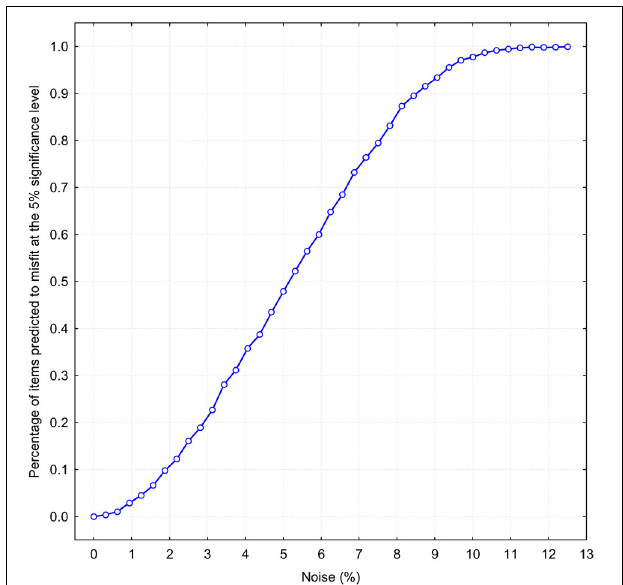
FIGURE 5 | Observed (blue) and predicted (red) response probabilities for the self-rated item i 112 (E5: Excitement-Seeking). The green shows a mixed-binomial approximation with two differently weighted binomial components p B and q B